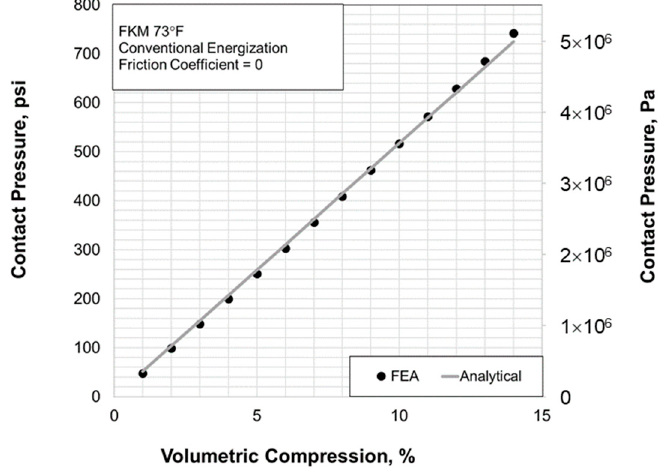
Figure 6. Comparison between contact stress simulated by FEA model and calculated using analytical equation.